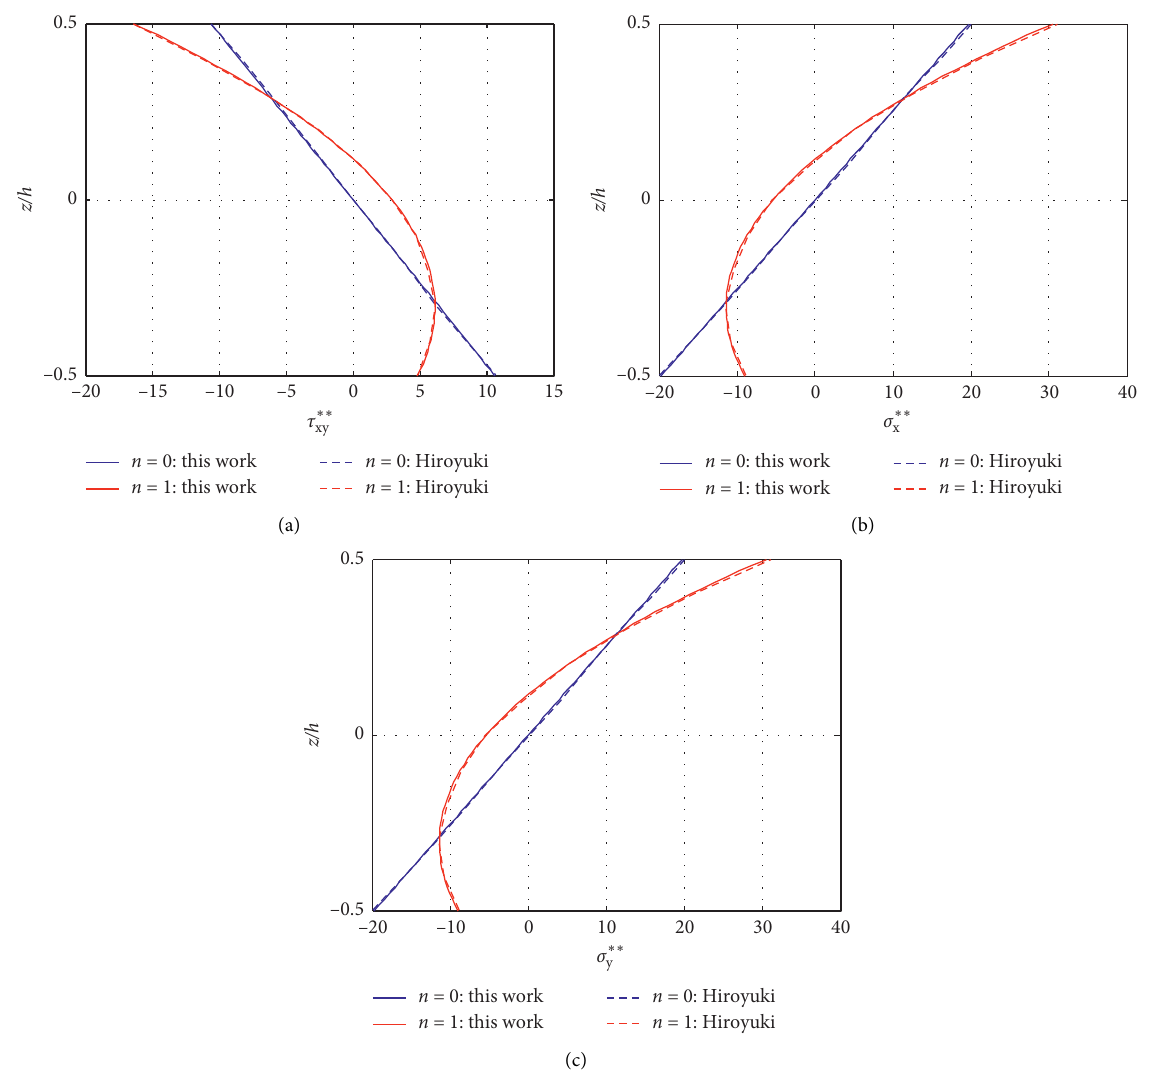
Figure 3: The comparison of the stress distribution of FGM subjected to bisinusoidal load: (a) τ ∗∗ (c) σ ∗∗ y (( a /2 ) , ( b /2 ) ,z ) .